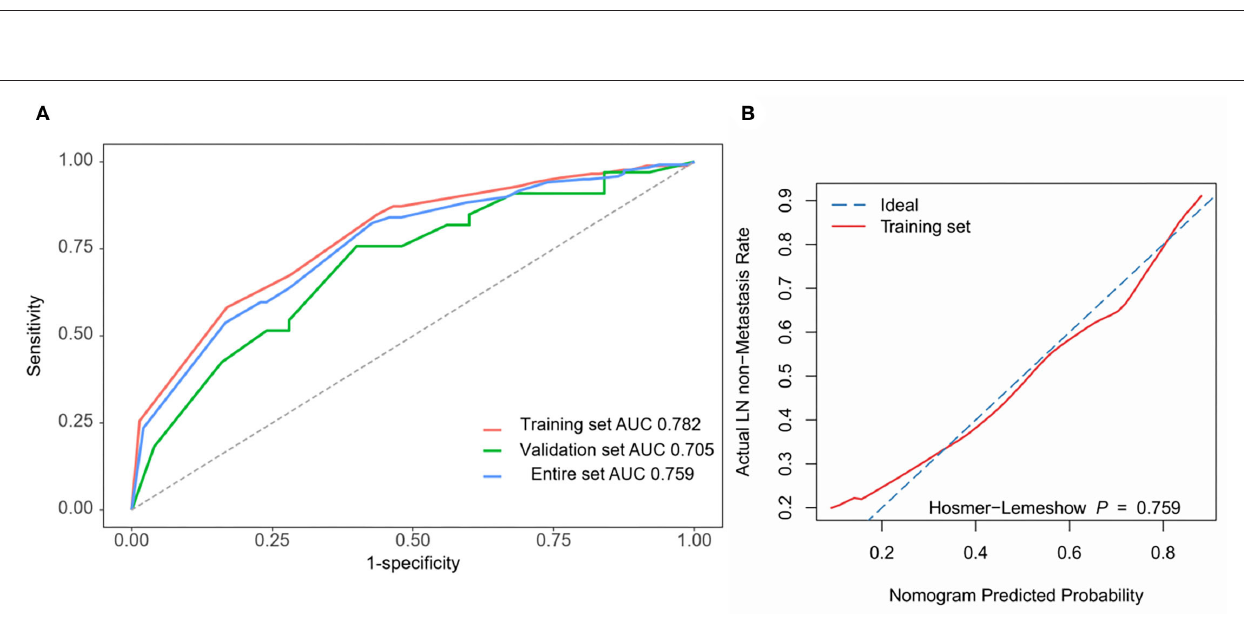
FIGURE 4 | Nomogram prediction model validation. (A) ROC curves are used for all sets. AUC values for training set (red), validation set (green), and entire set (blue) are 0.782, 0.705, and 0.759. (B) The bootstrapped calibration plot and Hosmer-Lemeshow test for the training set.